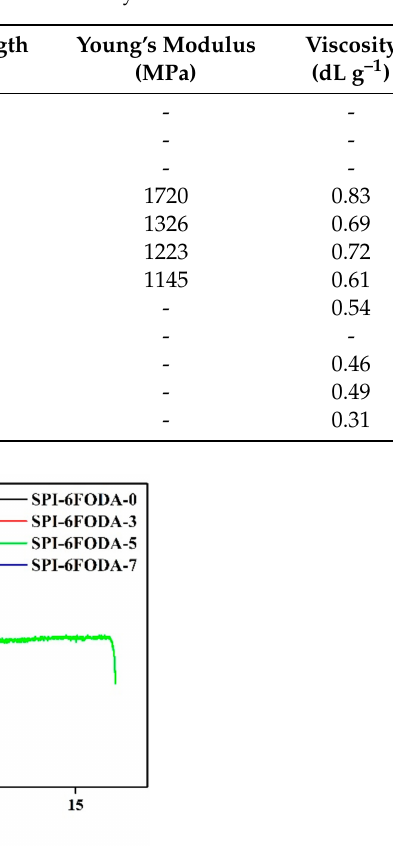
Figure 5. TGA curve of ( a ) SPI-ODA based membranes, ( b ) SPI-6FODA based membranes, and ( c ) SPI-BFDA based membranes. Table 2. Tensile strength, thickness, Young’s Modulus, and viscosity of three series of SPIs.